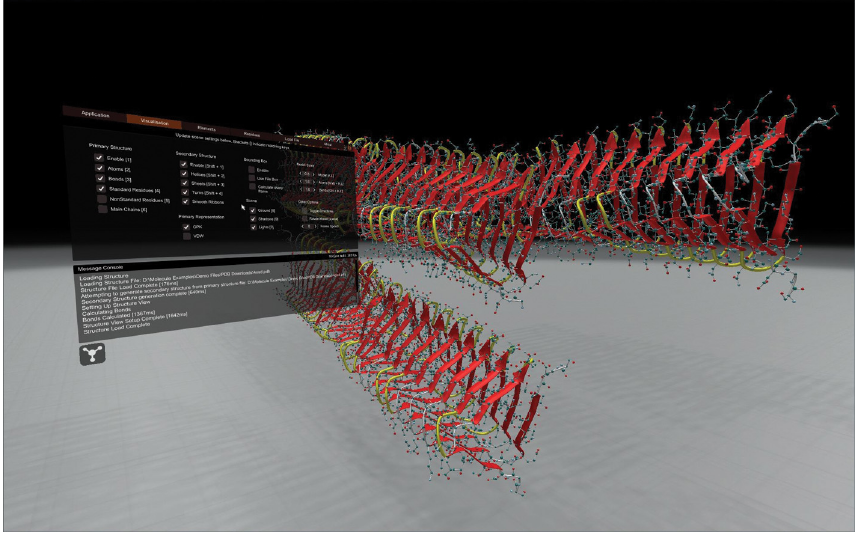
Figure 2: User interface in 3D on stereoscopic